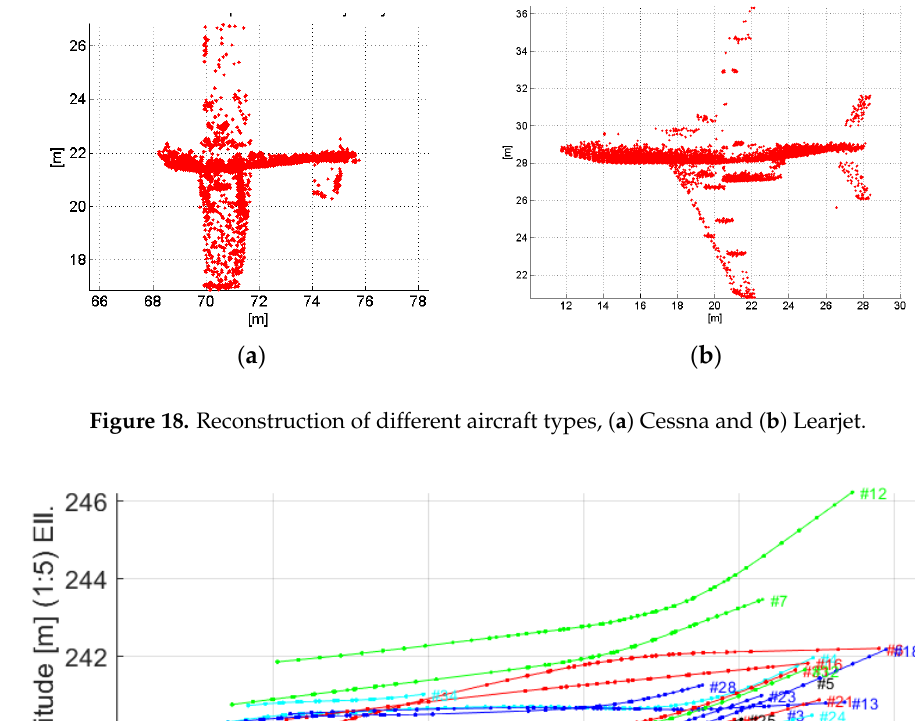
Figure 17. Aircraft tracking: ( a ) current video frame (), ( b ) altitude profile with blue dashed line showing the error envelope in cm, red line is the runway surface, and ( c ) 2D trajectory.